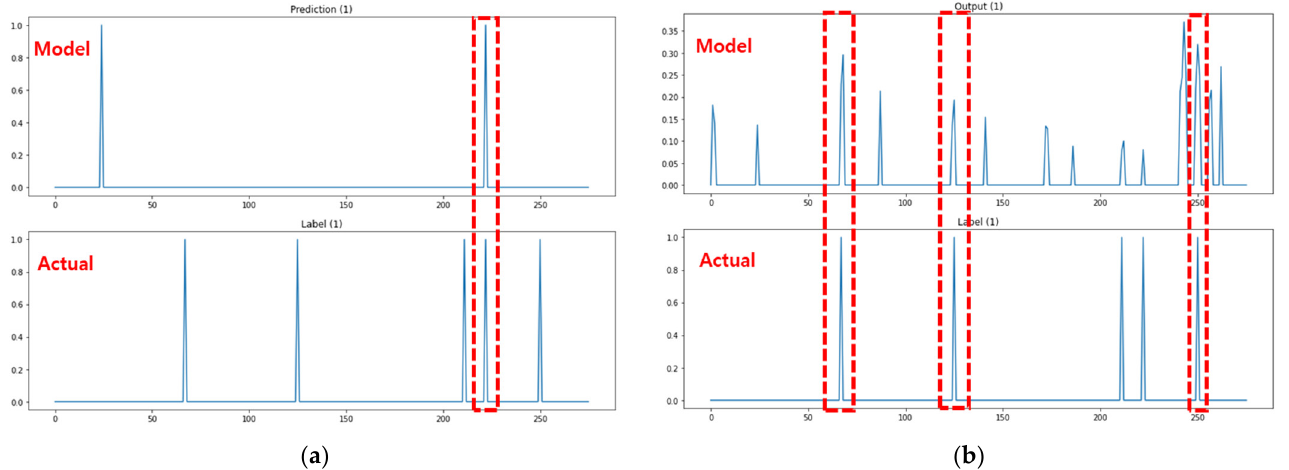
Figure 9. Example of the classification and prediction model results. ( a ) Classification model. ( b ) Prediction model.